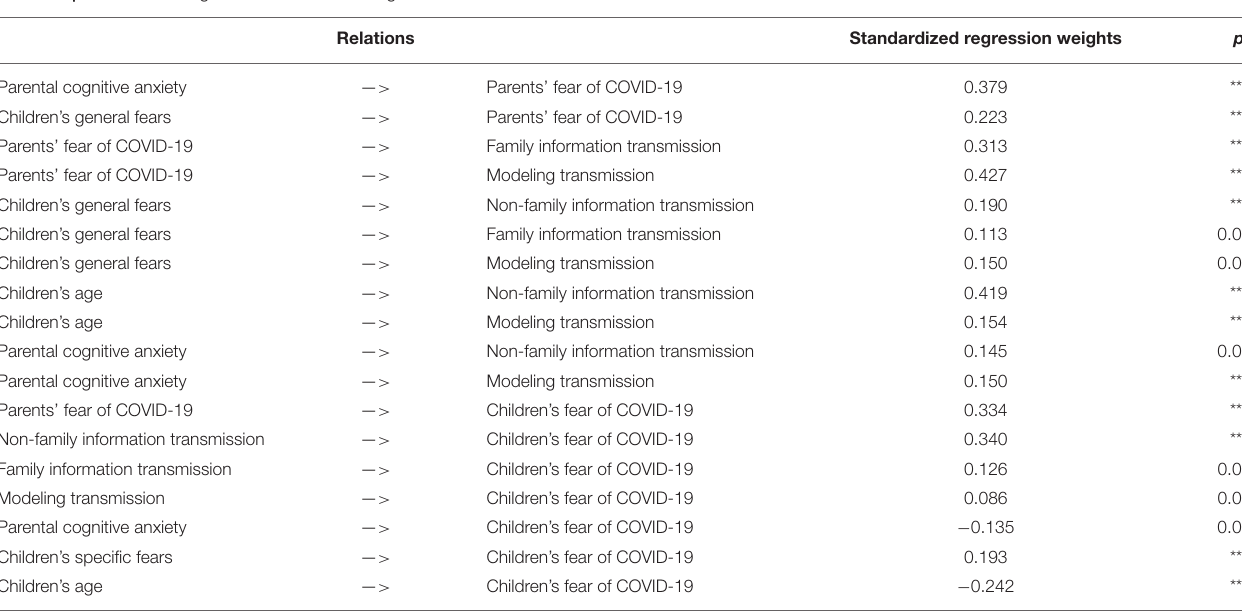
TABLE 2 | Standardized regression coefficient for regression